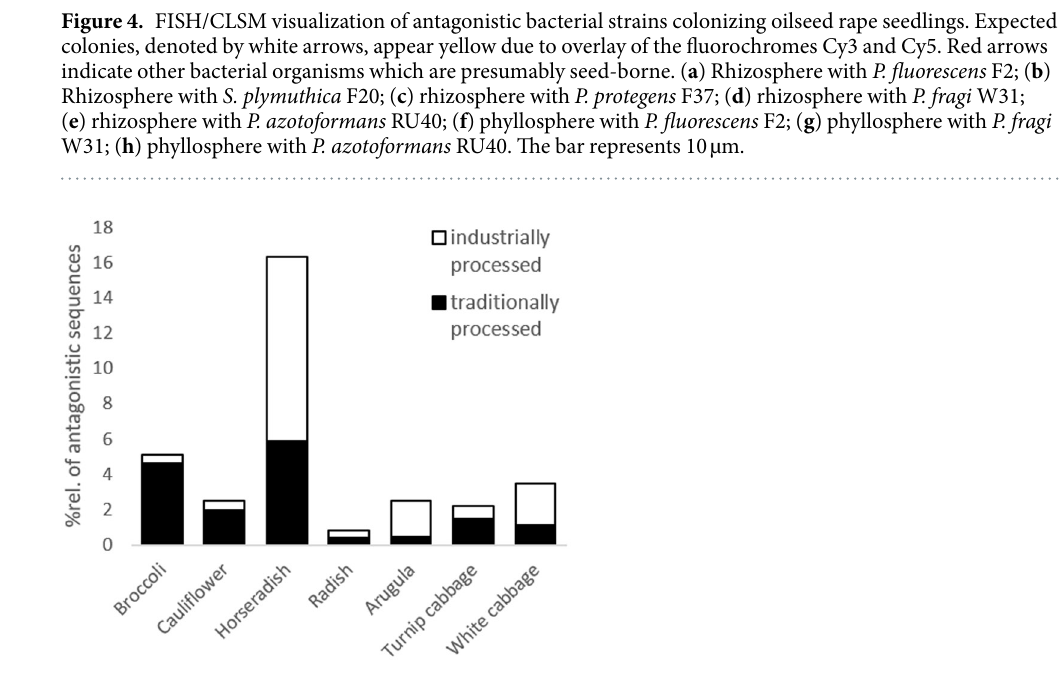
Figure 5. Verticillium -antagonistic sequences within the vegetable microbiomes. Columns represent the relative amount of sequences (%) assigned to isolated Verticillium -antagonistic bacteria (listed in Table 2) in the 16S rRNA gene library of each vegetable genotype. Columns are subdivided in traditionally processed (filled columns) and industrially processed (open columns)